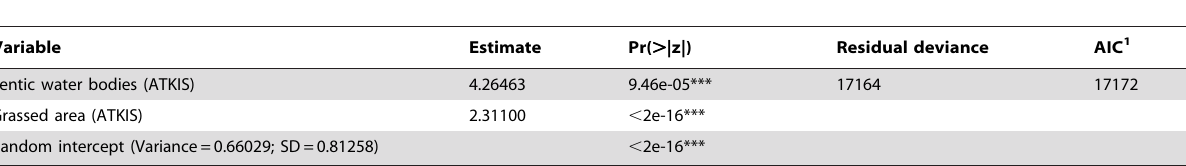
Table 5. General linear mixed model with random intercept.